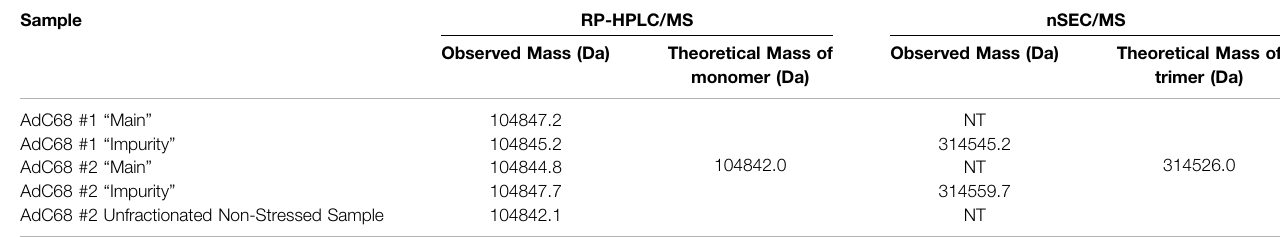
TABLE 3 | Observed Masses for deconvoluted hexon by RP-HPLC/MS and nSEC-HPLC/MS. Sample